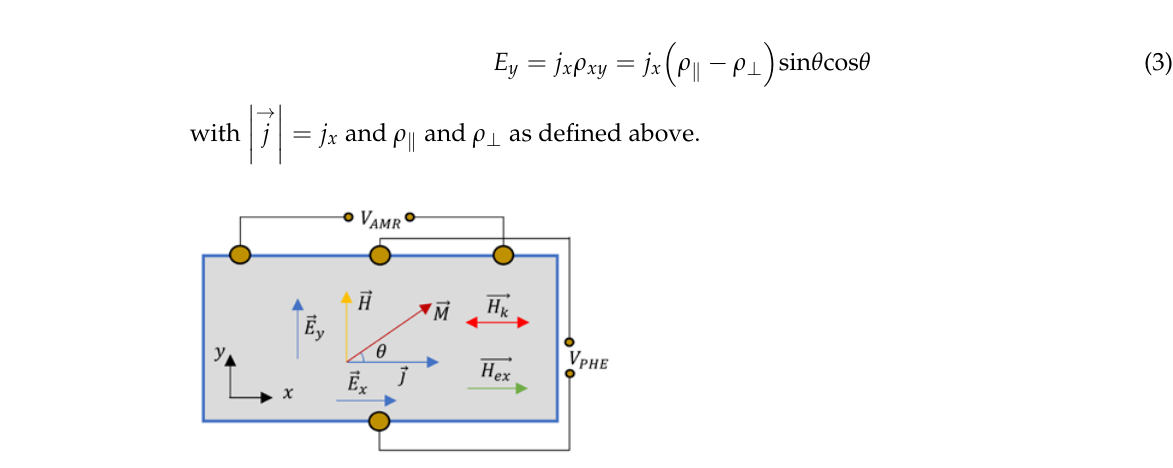
Figure 1. Schematic representation of the AMR and PHE effects on a Permalloy thin film through which a current is flowing along the x axis; the current direction due to the applied field,